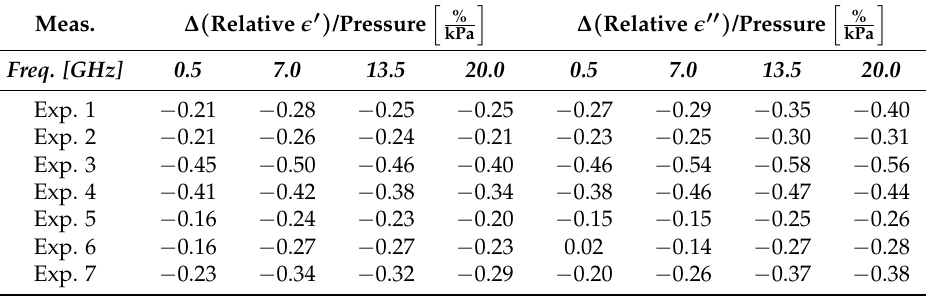
Table 2. Linear slopes of relative changes in complex permittivity per kPa at the frequencies from Figure 7.